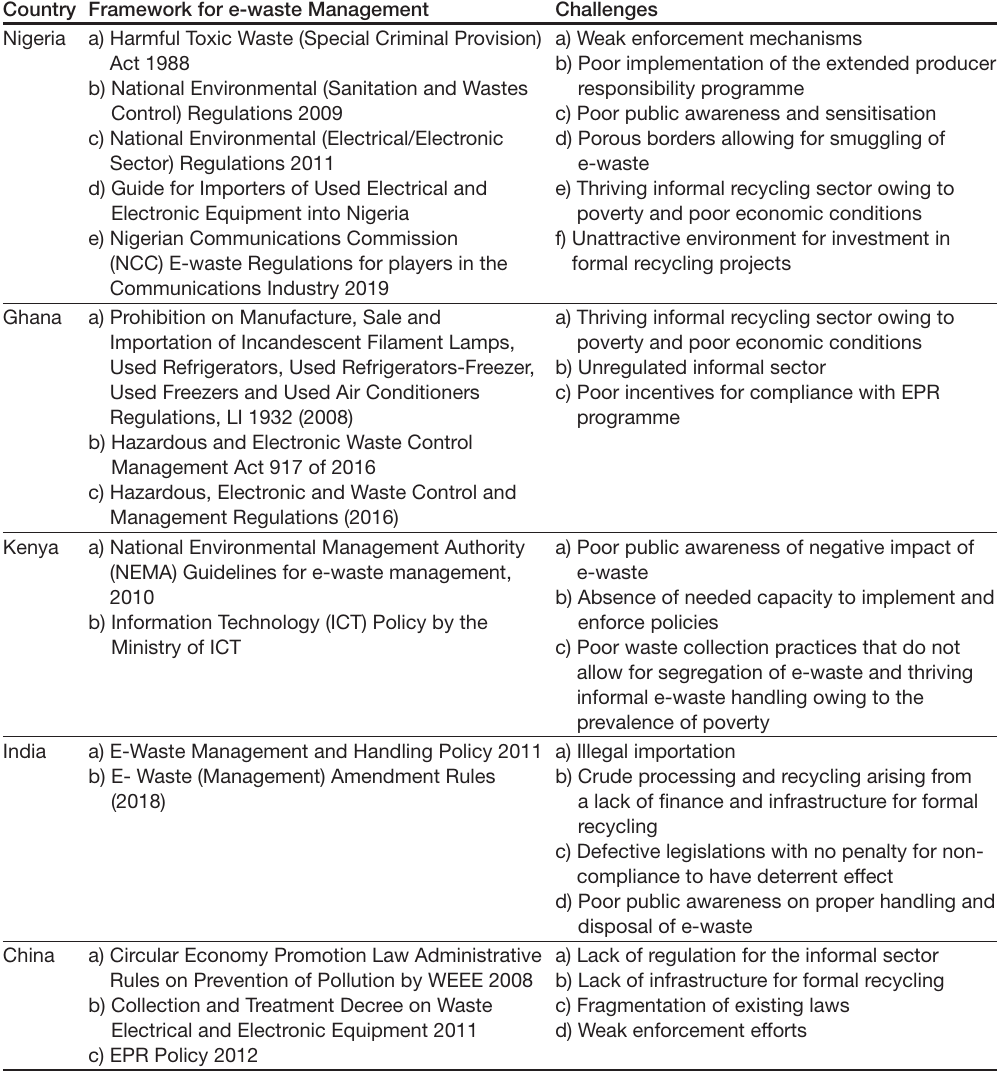
Table 1. Summary of e-waste management framework in some developing countries and identified challenges Country Framework for e-waste